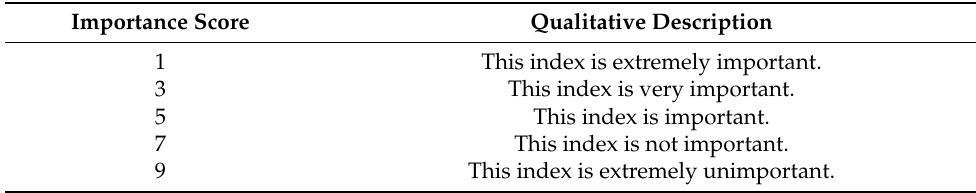
Table 3. Index importance scoring